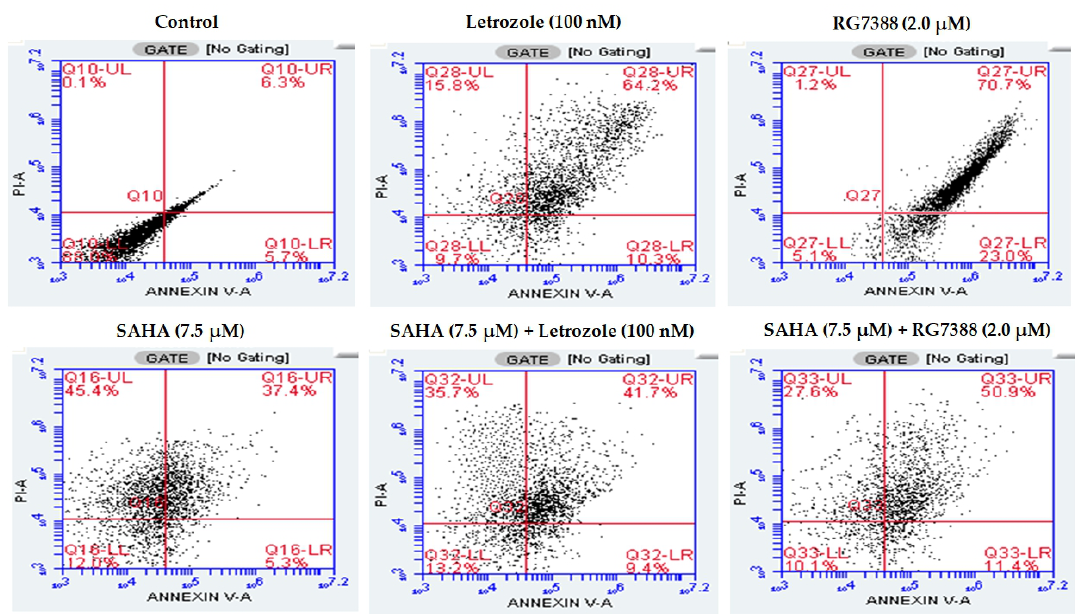
Figure 2. Apoptosis, necrosis, and necroptosis analysis by flow cytometry using Annexin